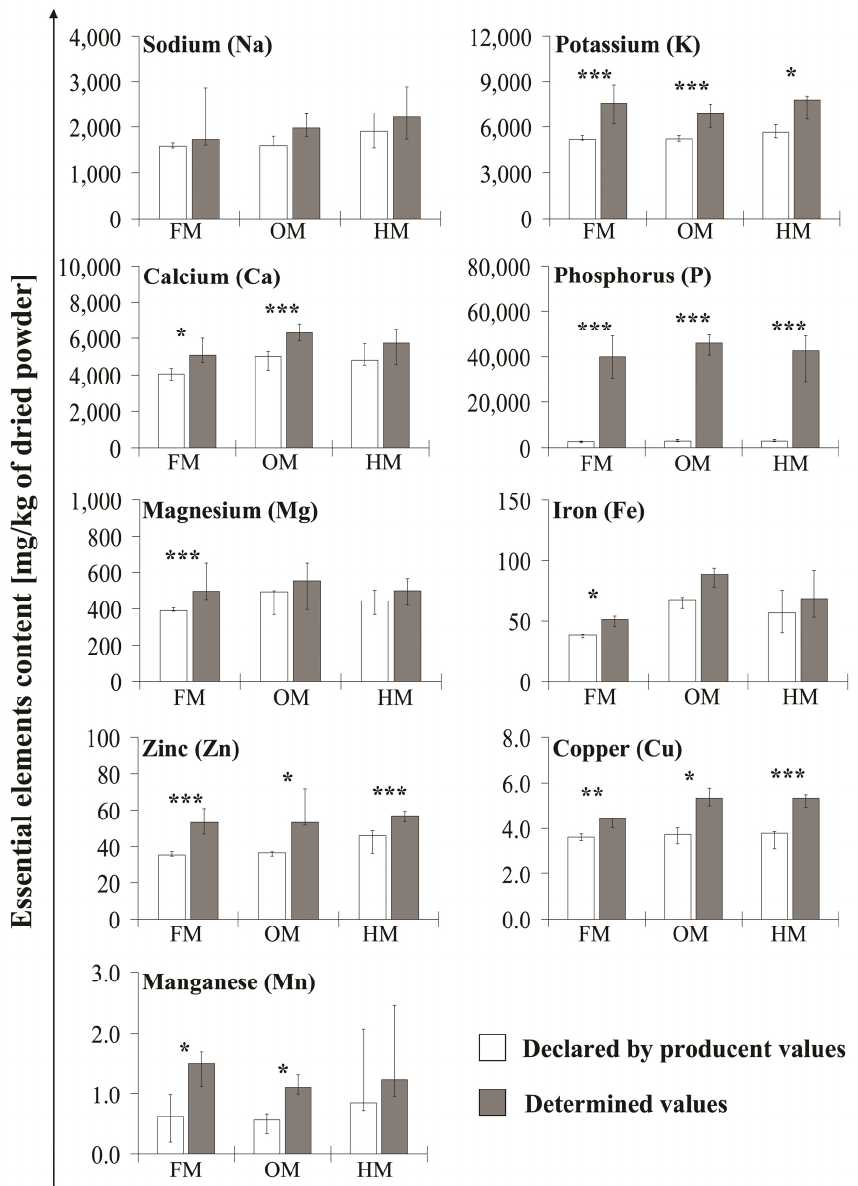
Figure 2. Composition discrepancies between obtained concentration values and declared by producers in analyzed baby milk. The comparison of obtained data with declared by producent content values presented on products labels. Data are presented as median (interquartile range) values of six experiments. FM—first baby milk, OM—follow-on milk, HM—hypoallergenic milk. The significance level of the differences observed: * p < 0.05; ** p < 0.01; *** p < 0.001.